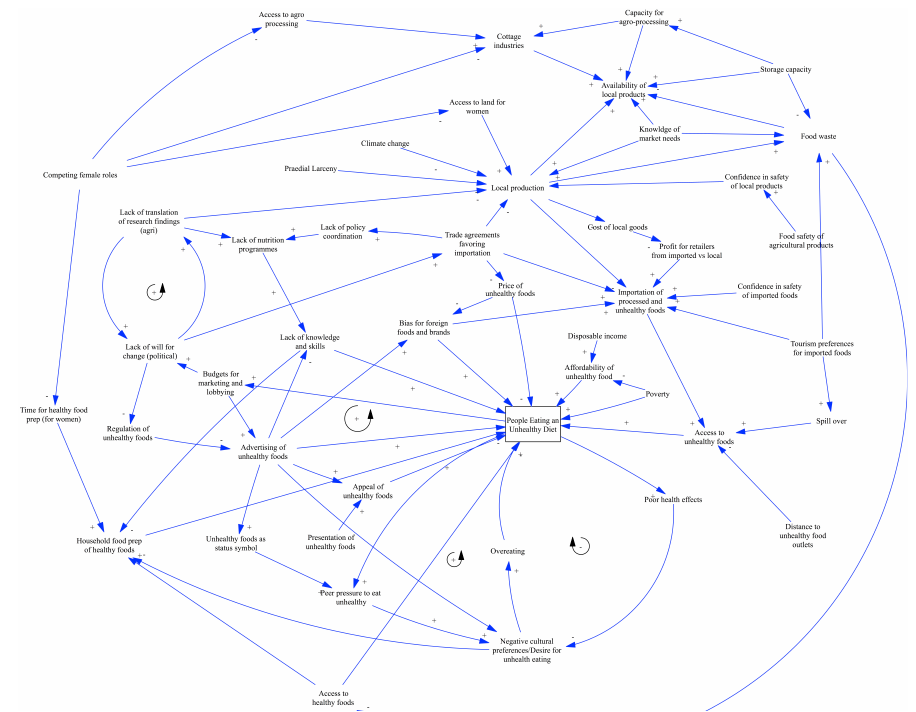
Figure 1b - Jamaica workshop room 2 preliminary causal loop diagram for unhealthy eating Figure A2. Jamaica workshop room 2 preliminary causal loop diagram for unhealthy